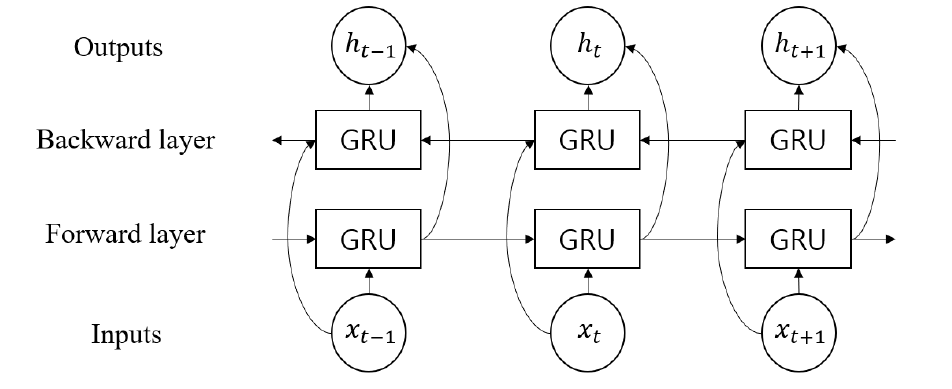
Figure 9. Structure of Bi-GRU.